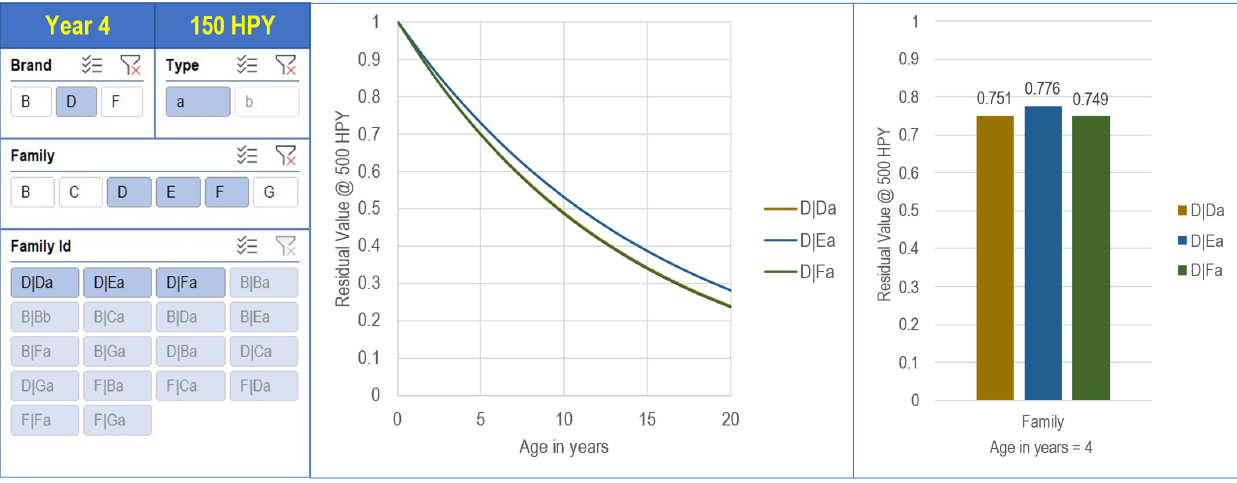
Figure 9. Residual value (value as new = 1) comparison of Brand D high performance combine families with 150 h per year